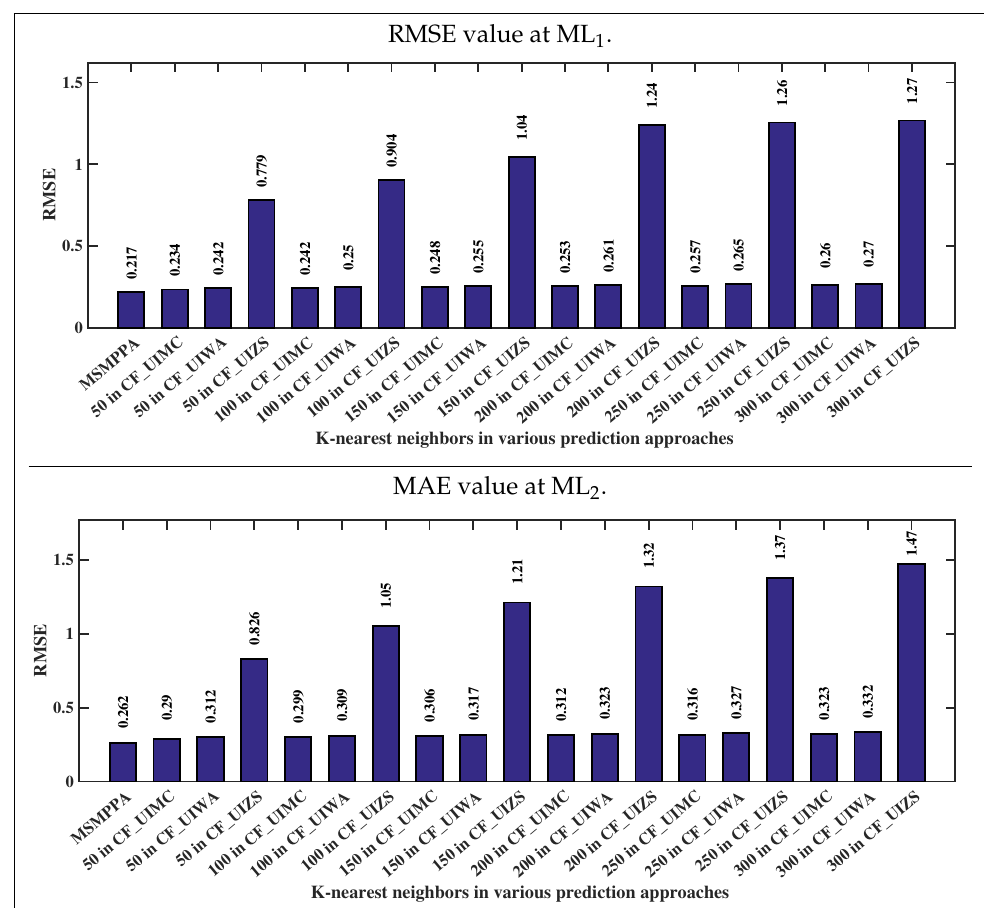
Figure 12. RMSE Value at